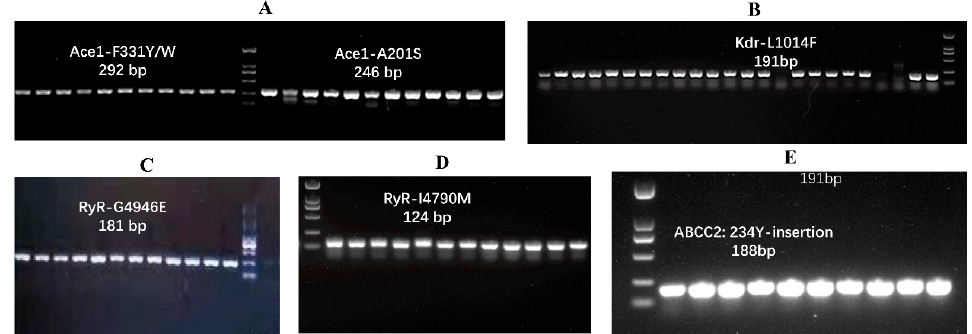
Figure 2. PCR amplification of DNA containing the resistance mutations. We display one figure per mutation with amplification size, which indicates that the DNA fragments containing the corresponding desired mutations were amplified as expected: ( A ) A201S and F331Y/W in Acetylcholinesterase Ace1; ( B ) L1014F in voltage-gated sodium channel (VGSC); ( C ) G4946E in ryanodine receptors (RyR); ( D ) I4790M in RyR; and ( E ) 234Y insertion in ABC transporter (ABCC2).